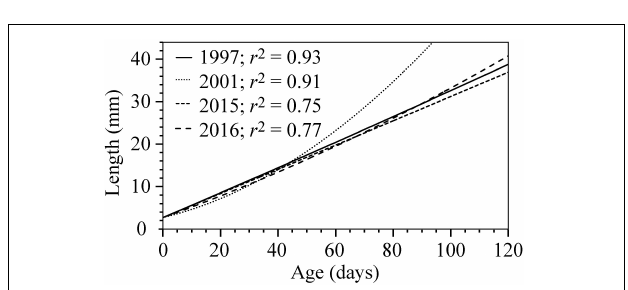
FIGURE 8 | Growth curves of 0-group cod on the Faroe shelf in 1997 ( n = 94), 2001 ( n = 116), 2015 ( n = 103), and 2016 ( n = 81) estimated from age and length together with goodness of fit ( r 2